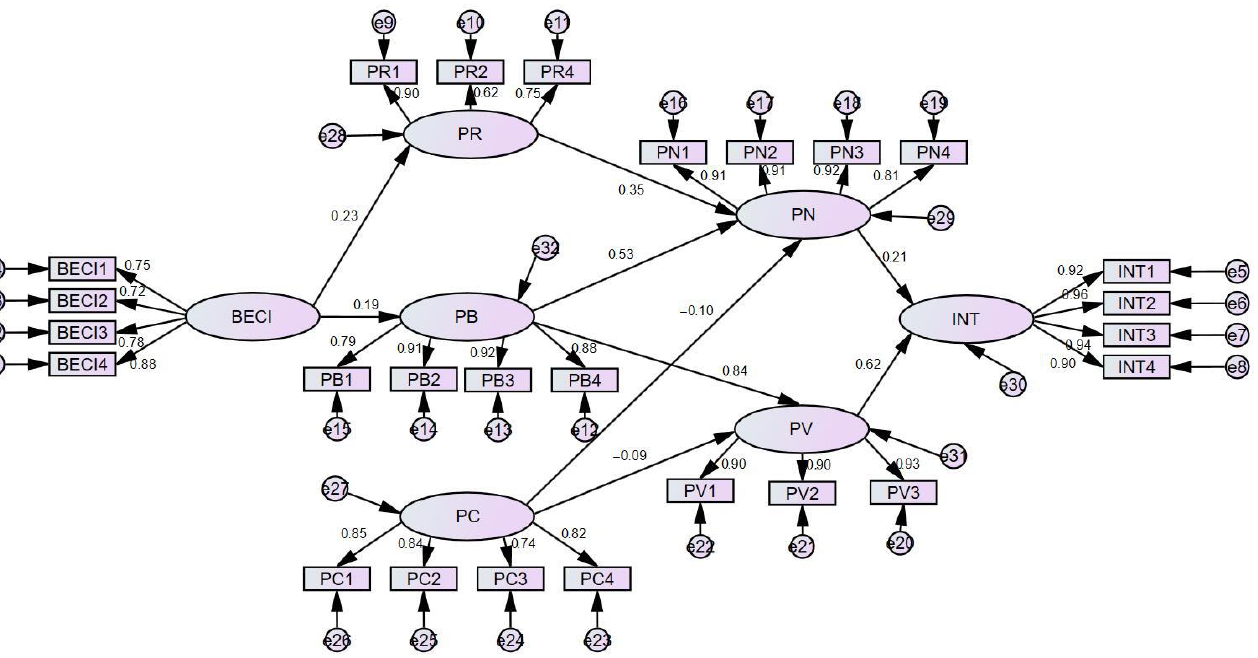
Figure 3. Theoretical model and its parameters. Table 4. Path coefficient estimation of the model.